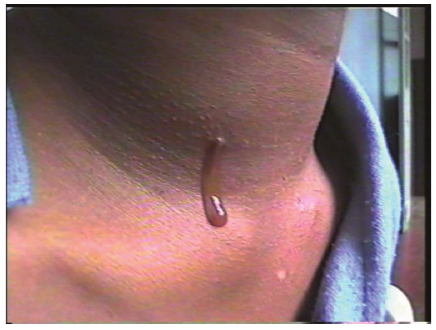
Figure 7: Saliva coming out of third branchial